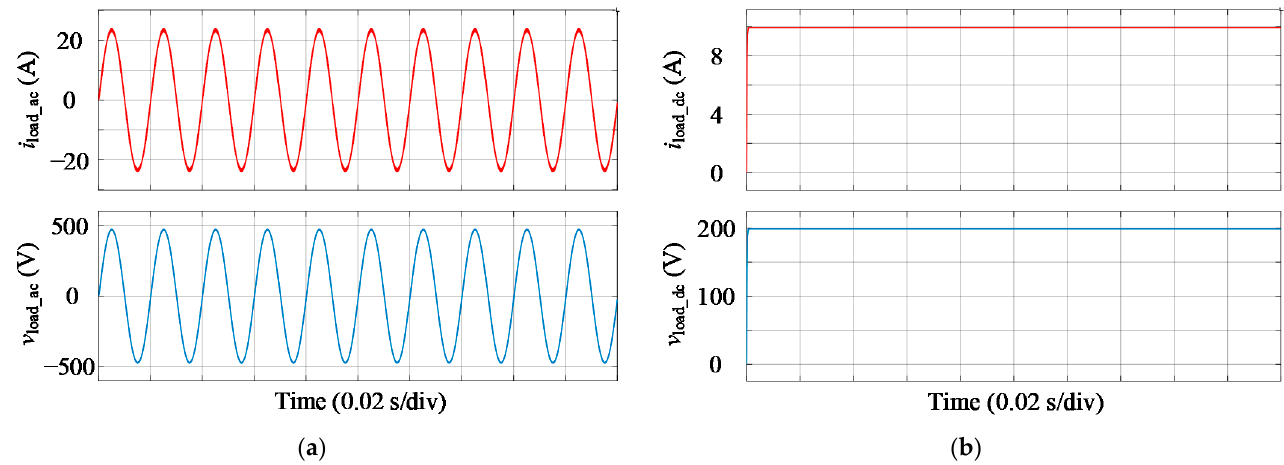
Figure 14. Simulation results of the lattice converter with multiple output ports: ( a ) ac output port; ( b ) dc output port.